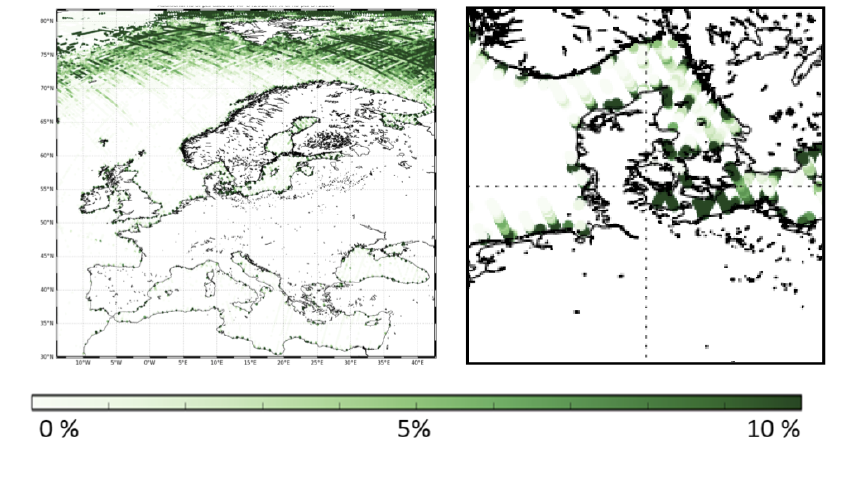
Figure 7. Relative increase in percentage of the number of point used to compute an Envisat/SARAL/AltiKa mean profile relatively to the previous a ERS-2/Envisat mean profile over: European Seas ( left ); and zooming over the Danish Straits ( right